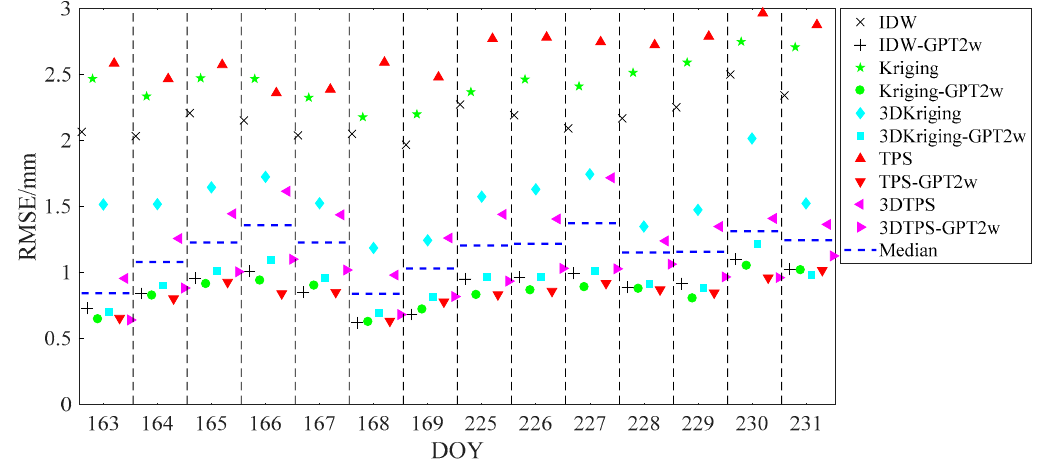
Figure 4. RMSE of di ff erent interpolation schemes on each day for station cross-validation.